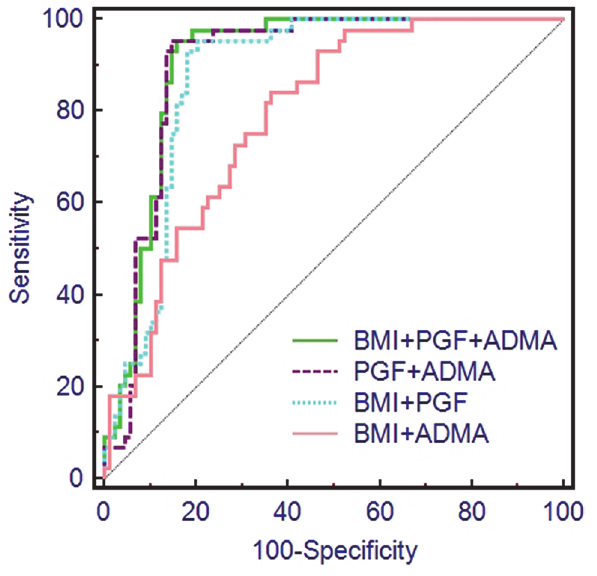
Fig 3. ROC curves of combinations of first trimester PGF levels, ADMA levels and BMI in prediction of preeclampsia.